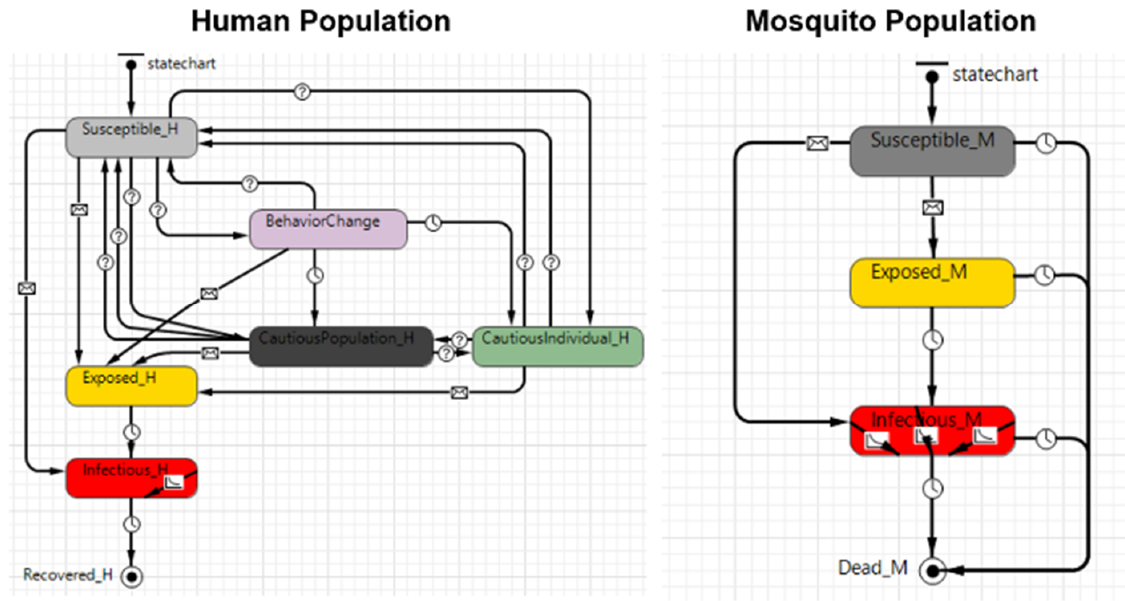
Figure 3. Snapshot of the simulation Model C (coupled human behavior and dengue spread model).